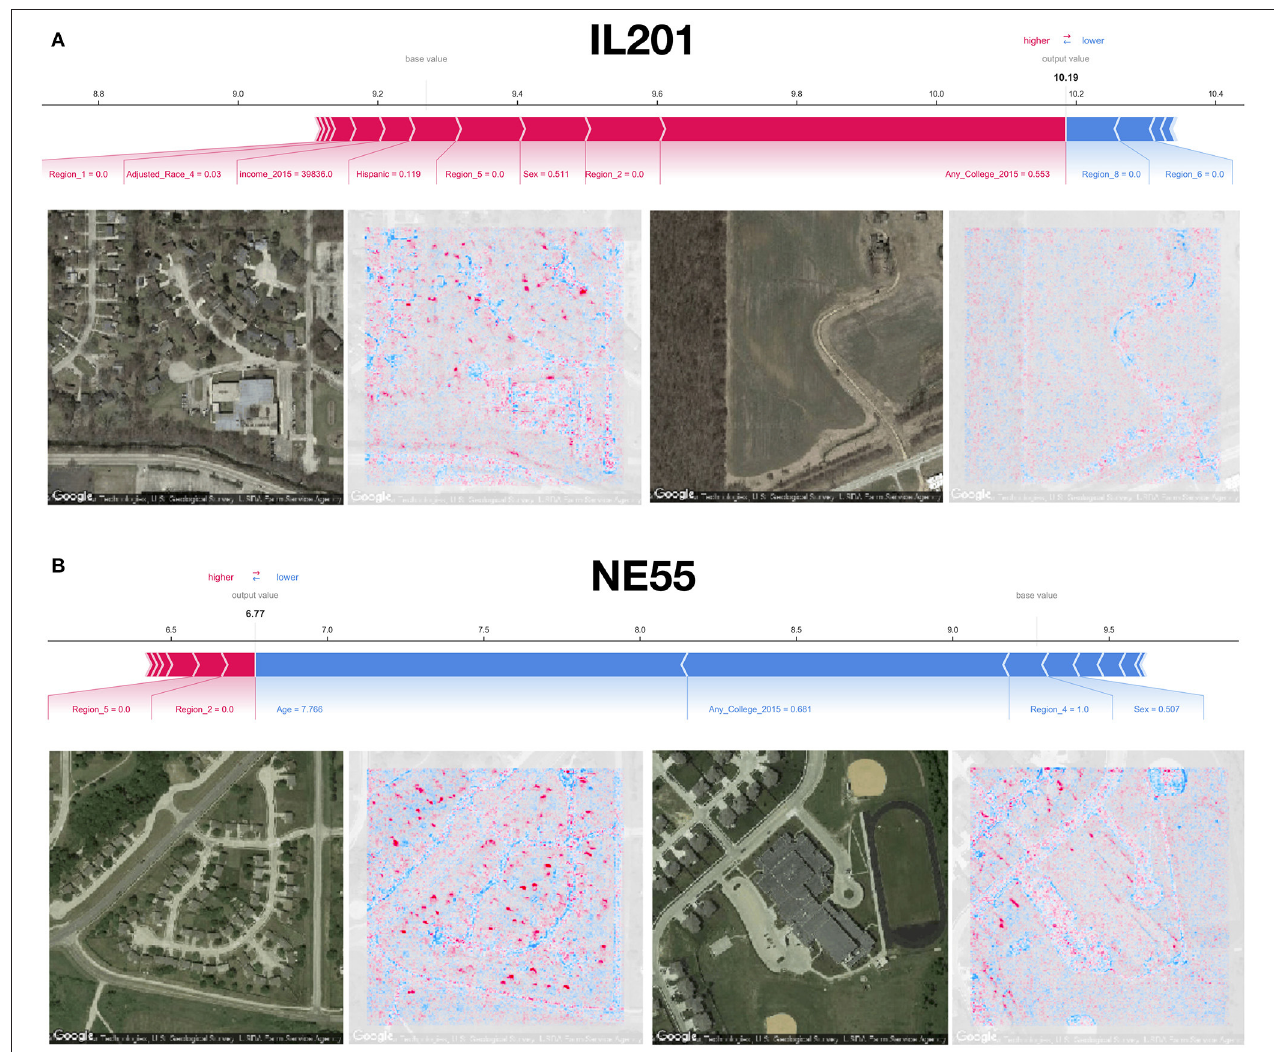
FIGURE 4 | SHAP image interpretations: (A,B) Shapley features extracted from both covariate and image models for select images from counties in Illinois and Nebraska (FIPS codes IL201 and NE55, respectively); blue coloring indicates features associated with reductions in mortality, red indicates association with increased mortality; additional image interpretations can be found in Figure 1D